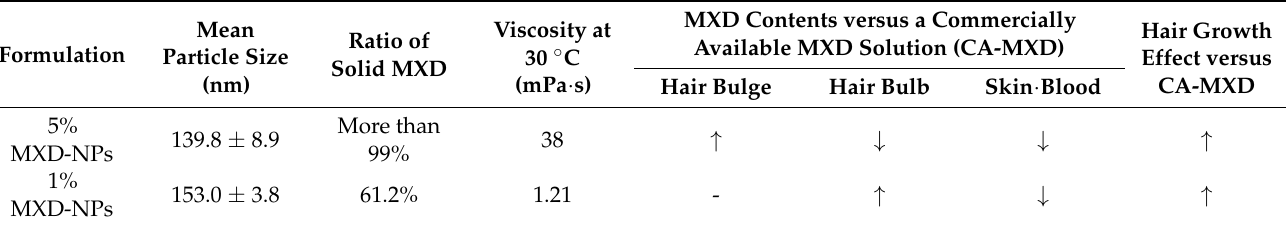
Table 2. Differences between 5% MXD-NPs and 1%